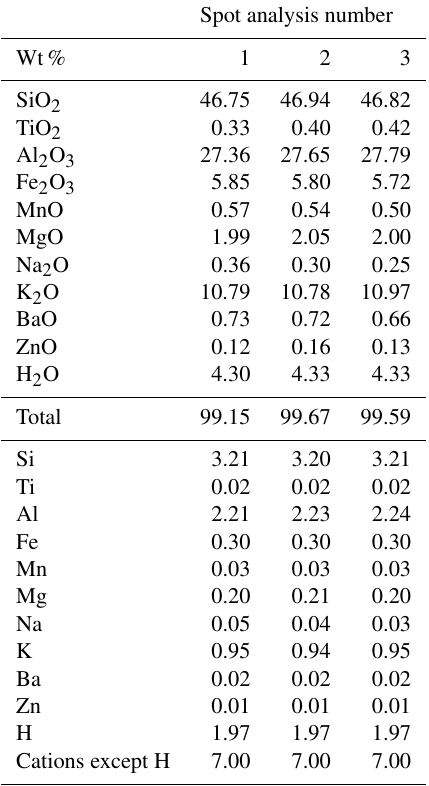
the number of cations, except H, to 16. Then the T positions Table 2. Representative microprobe analysis of red mica associated with ardennite-(As) in mica schist from Nežilovo. are solved by collecting Si, As, V and P cations. If there is more than 6 apfu in the T position, the excess V is assigned Spot analysis number to octahedrally coordinated sites as V 3 + , and if there are in- sufficient cations, the lack is compensated for with Al. Then, 3 the amount of OH is determined by the requirement of elec- troneutrality. At the end, if (Ca + Mn) content exceeds 4 apfu, then the excess Mn is assigned to octahedrally coordinated sites as Mn 3 + . The formula of the studied ardennite-(As) fol- lowing this approach